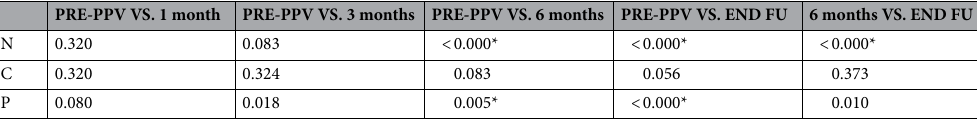
Table 2. Cataract development for each LOCS III type over the main follow up timepoints. PPV pars plana vitrectomy, FU follow up, N nuclear cataract, C cortical cataract, P posterior subcapsular cataract. *statistical significance achieved.